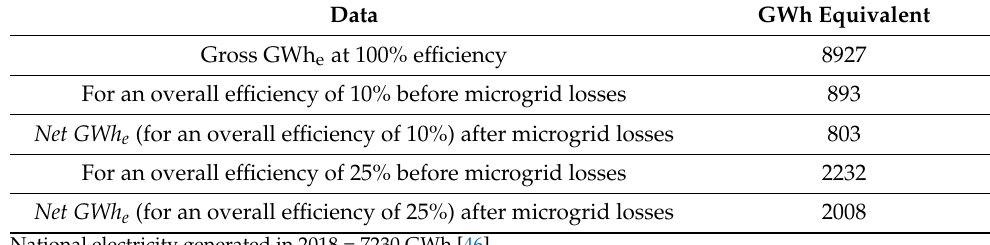
Table 10. Summary of the electrical generation potential from livestock residues.